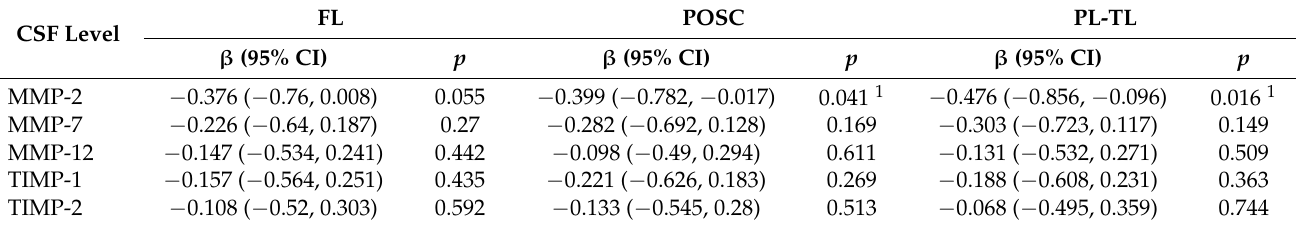
Table 3. Multiple regression model between CSF MMPs and TIMPs levels and PiB uptake in each brain ROI.